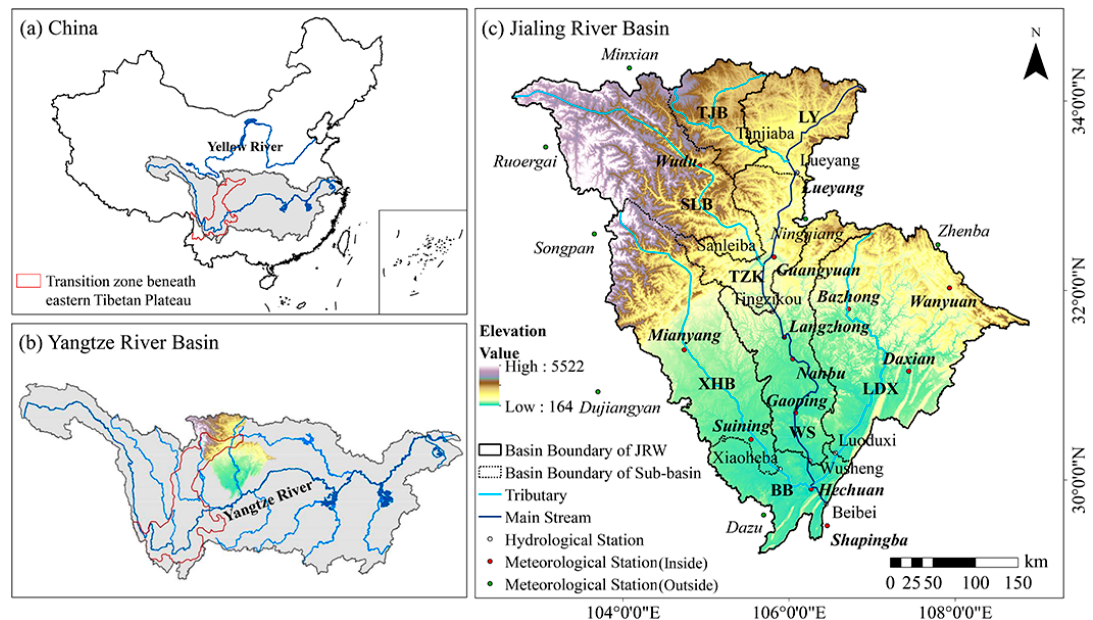
Figure 1. Location and elevation of the JRW and hydrometeorological stations.